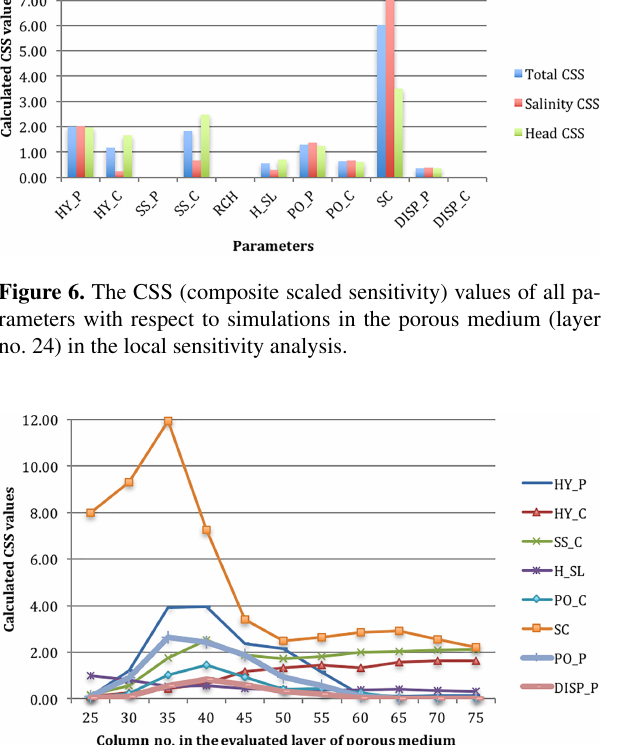
Figure 7. The CSS (composite scaled sensitivity) values at different locations in the porous medium (from column no. 25 to column no. 75 at layer no. 24) in the local sensitivity